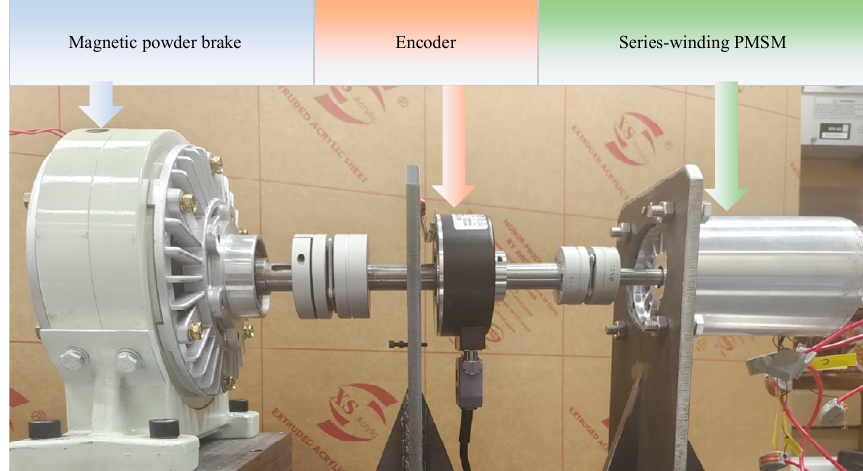
Figure 19. Experimental platform.